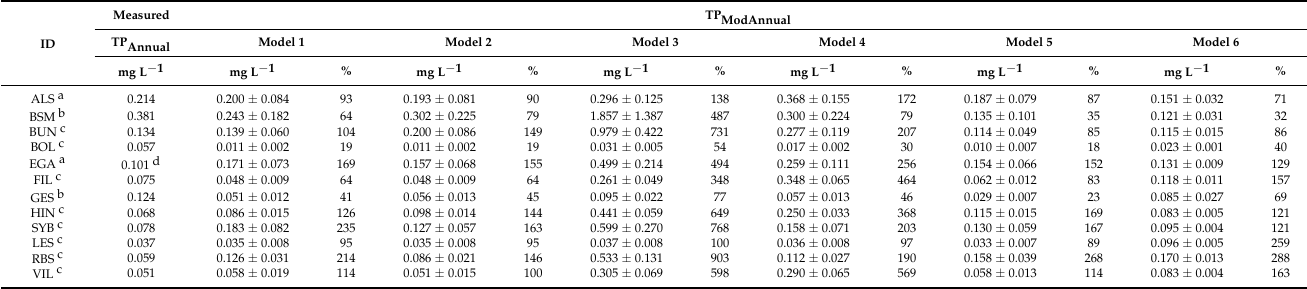
Table 3. Modeled average annual TP-concentration (TP ModAnnual ) and the proportion of the measured TP Annual .